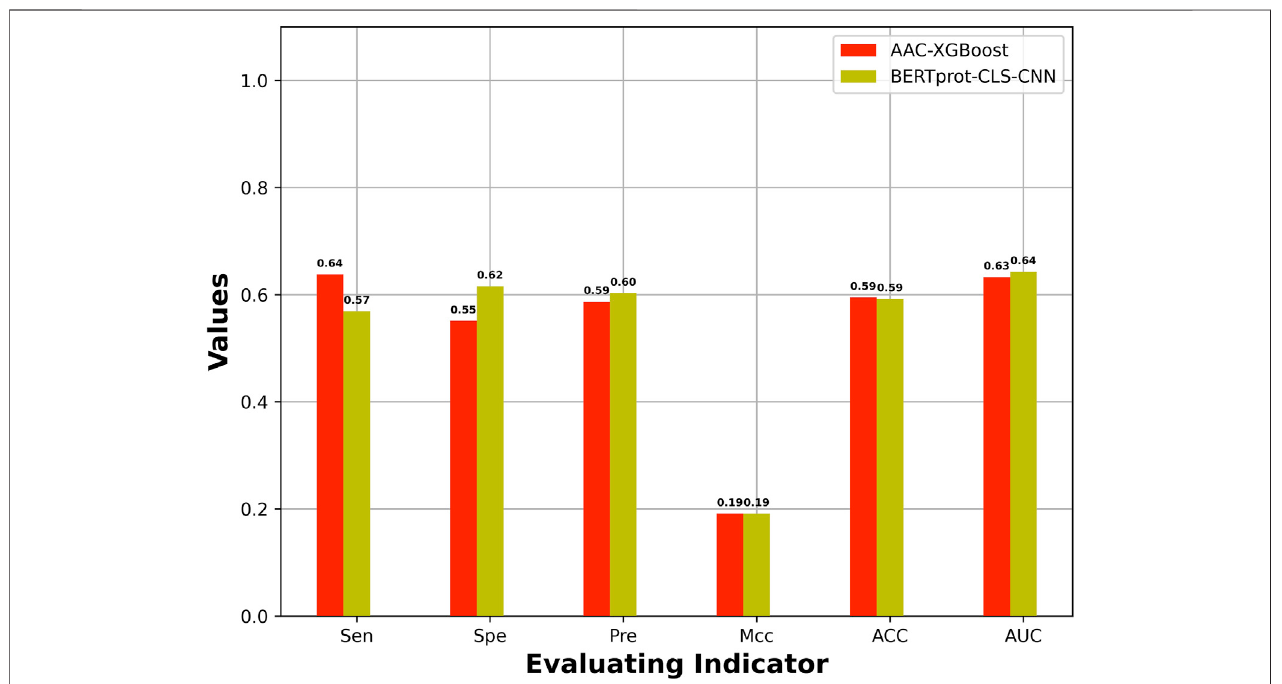
FIGURE 3 | Comparison of performance between the best model based on HCFs and the embeddings extracted from pretrained BERT model.